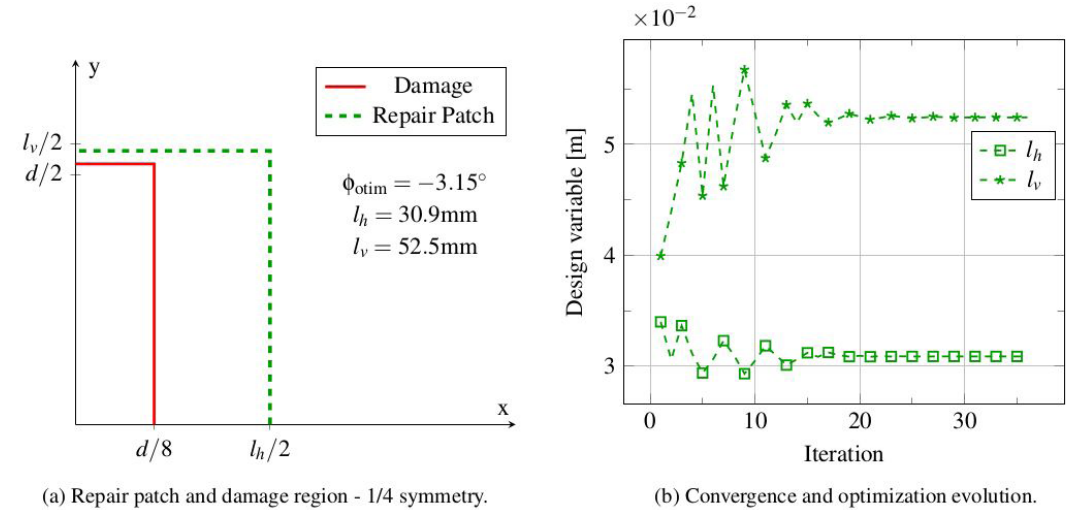
Figure 2. Rectangular repair patch - FC with symmetric stacking sequence.